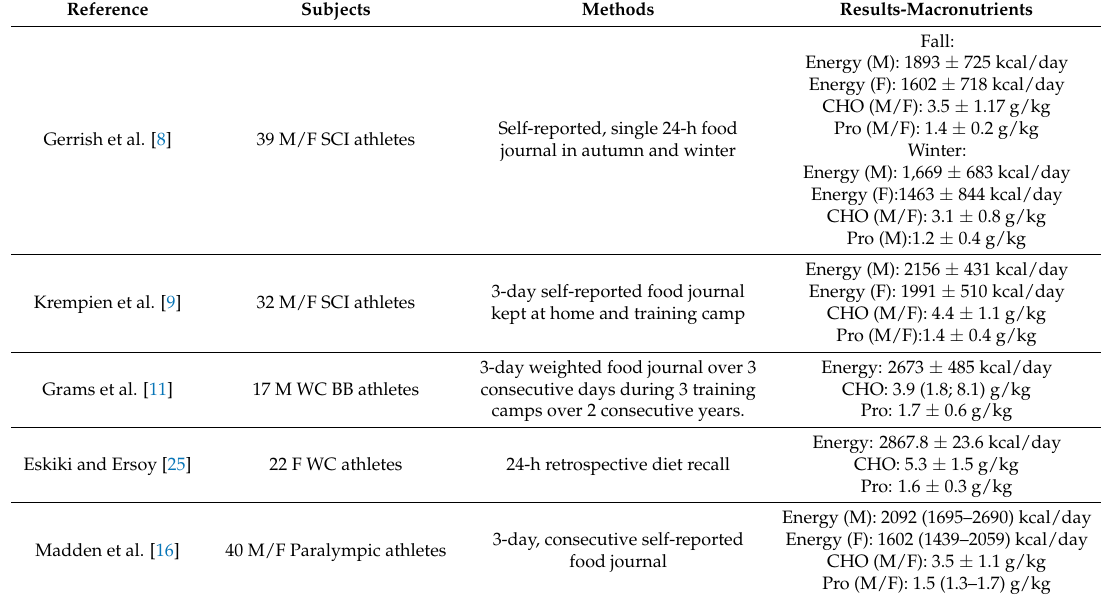
Table 3. Overview of studies examining macronutrient intake of para